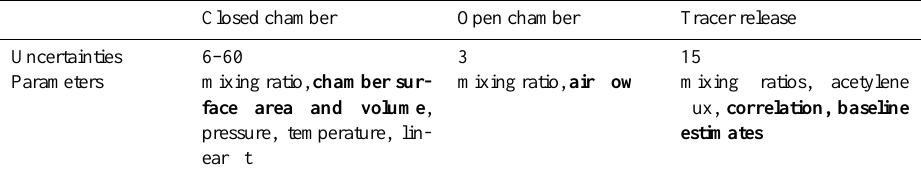
Table 4. Summary of the uncertainties resulting from the different methods (in percent). The parameters with the higher uncertainty are in bold.